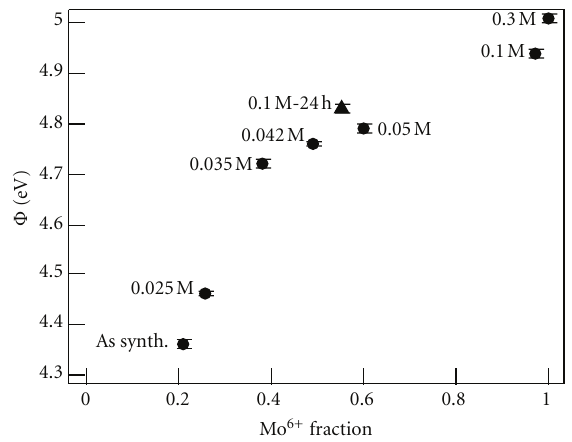
Figure 4: Φ versus Mo 6+ fraction for npMoO x as-synthesized and chemically oxidized at 0.025 M, 0.035 M, 0.042 M, 0.05M, 0.1 M, and 0.3 M H 2 O 2 concentrations for 1hr (circles) and at 0.1 M H 2 O 2 for 24 hour (triangle), showing a positive correlation between the two